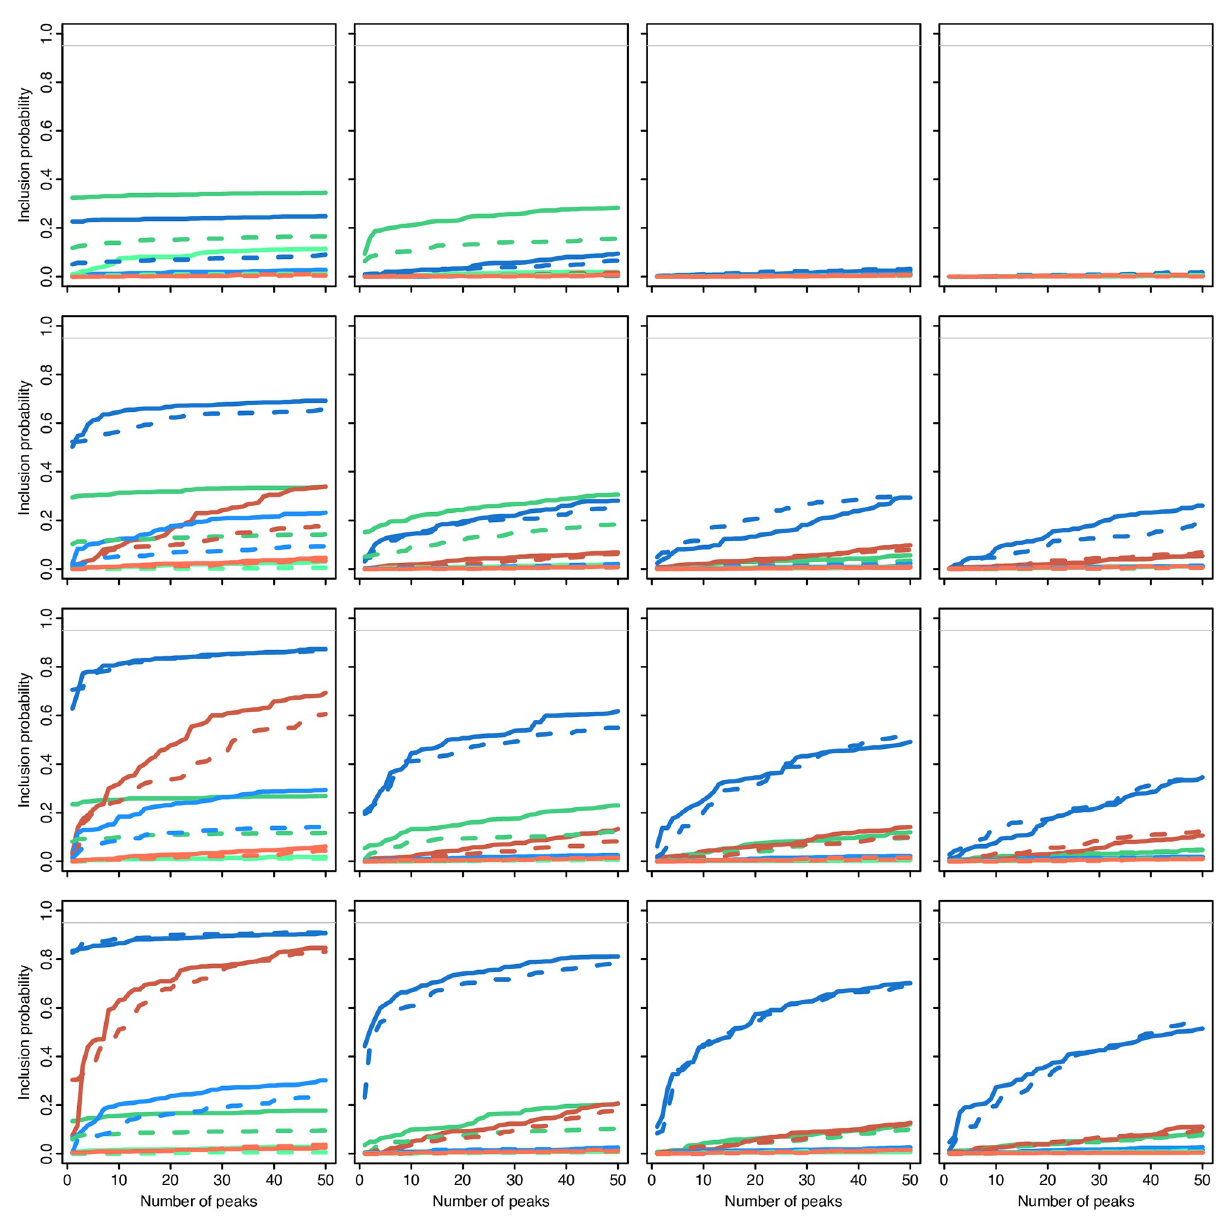
Fig 5. Detection probability of an introgression sweep (admixed background). Probability of an introgression sweep event to be detected in a genome-scan analysis using VolcanoFinder (blue), BALLET (brown) and SweepFinder2 (green). The x-axis in represents the number of false- positive peaks from the neutral data which score higher than the true-positive signal. The donor species diverged from the recipient species at (top to bottom) T = 1, 2.5, 4, 5.5 ( i.e . D = 3 θ , 6 θ , 9 θ , 12 θ ) and the selective sweep ended (from left to right) T d past. Solid lines: no polymorphism in the donor species (hard introgression sweep). Dashed lines: polymorphism exists in the donor species (possible soft introgression sweep). Dark colour: 2 Ns = 1000; light colour: 2 Ns = 100. Analyses involved a neutral admixed genomic background with the same level of admixture as a